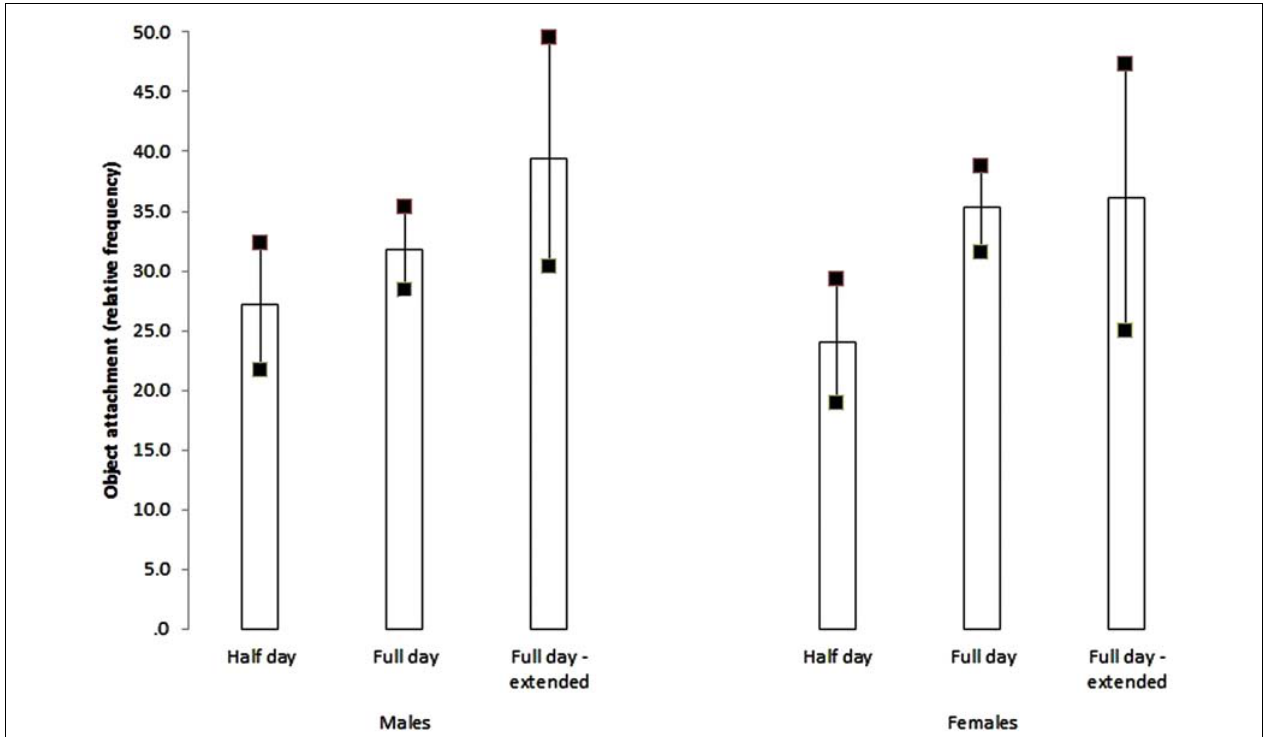
FIGURE 1 | Prevalence (and 95% confidence intervals) of children’s object attachment by time spent daily in non-maternal